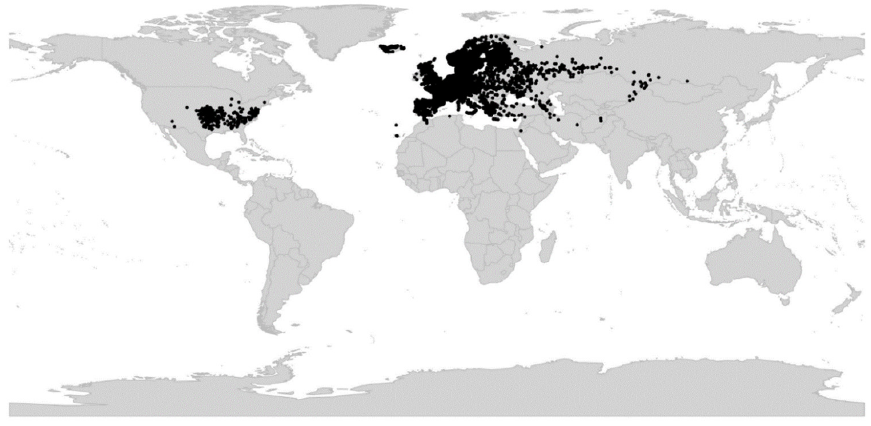
Figure 20. Global distribution of Viola sect. Melanium .